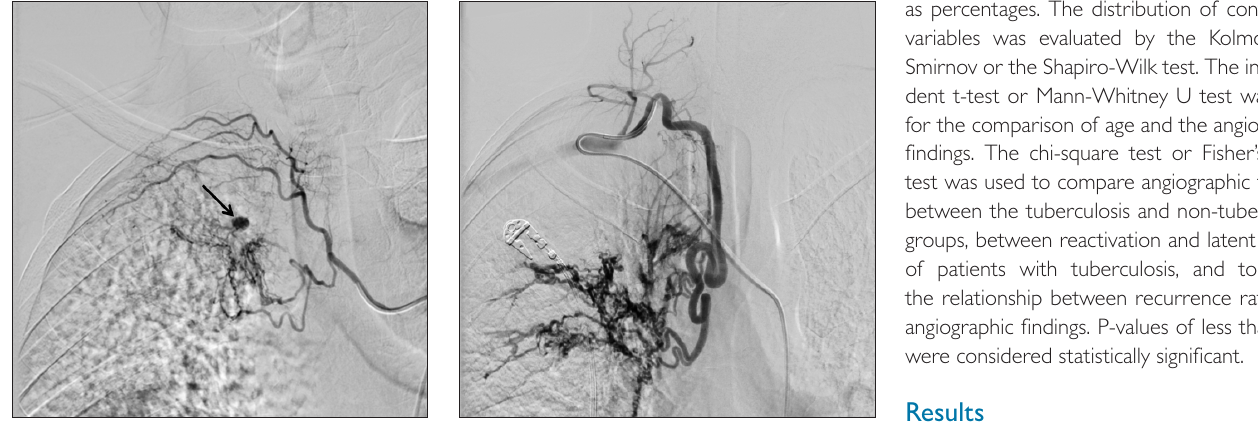
Figure 2. Right intercostobronchial arteriogram Figure 3. Patient referred with hemoptysis after demonstrates hypervascular areas and extravasation right intercostobronchial trunk embolization. (black arrow) in the right upper lobe Right costocervical trunk angiogram shows the hypervascular lesion with hypertrophy and Table 1. Angiographic findings of tuberculosis and non-tuberculosis patients Total number of patients